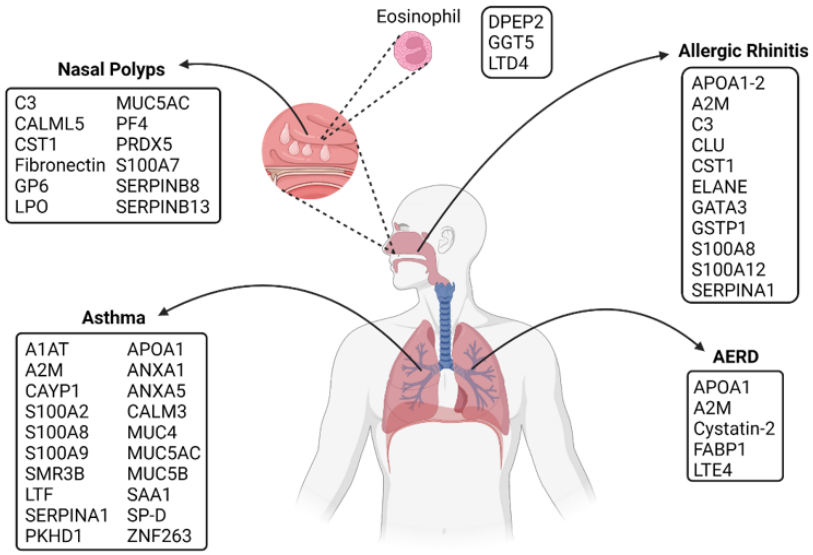
Figure 3. Potential diagnostic proteins found by proteomic technologies in upper and lower respiratory allergies. A non-exhaustive list of potential proteins described in diagnosis and treatment for asthma, nasal polyps, allergic rhinitis, and AERD. The same proteins are found in various allergy diseases like A2M, APOA,1 C3, CST1, SERPINs, some members of the S100 family, and Mucins. The principal pathways involved in these allergic diseases are mucus production, coagulation, inflammatory response, protease inhibition, cytokines synthesis, and membrane reparation. Created with BioRender.com (accessed on 10 May 2022).